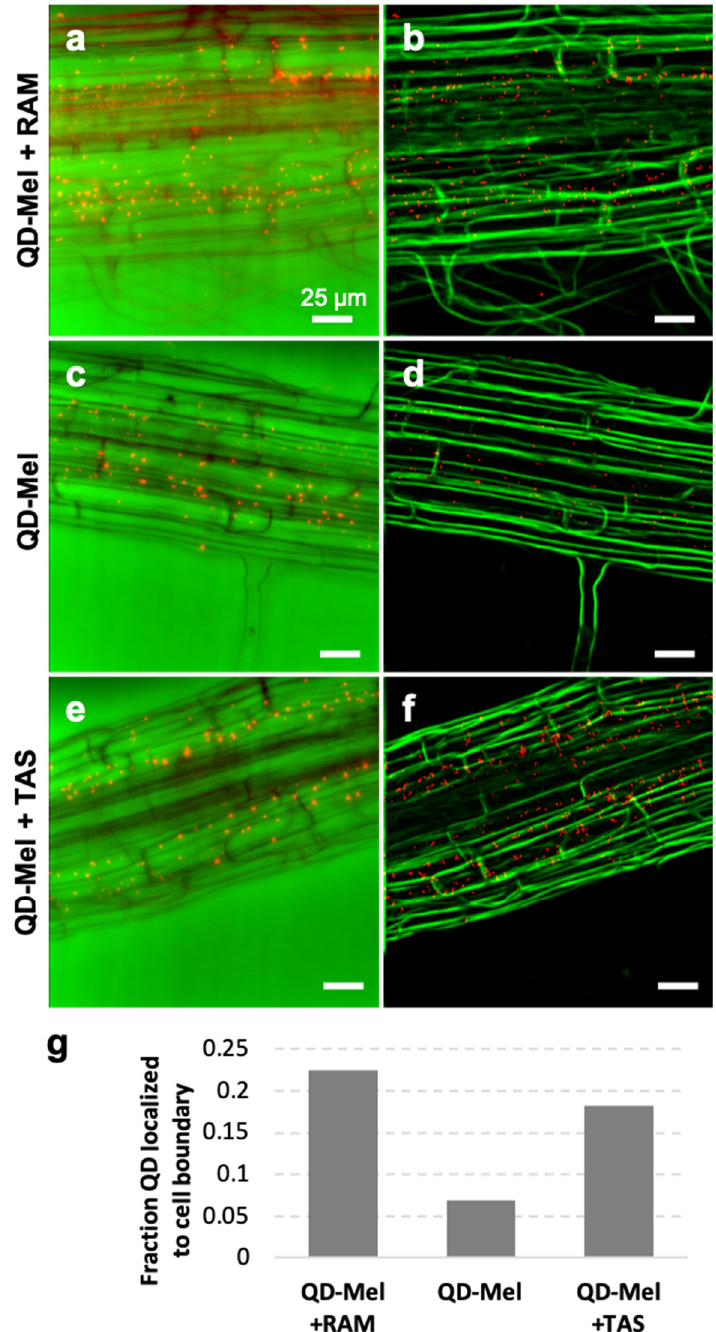
Figure 4. Arabidopsis thaliana roots treated with ramelteon + QD-MEL ( a , b ), QD-MEL alone ( c , d ), and tasimelteon + QD-MEL ( e , f ) seen under 40 × magnification with mCherry fluorescent filter. Images are pseudocoloured to show QD-MEL in red and overlaid on brightfield images in green; ( a , c , e ) are 2D projections of raw Z-stacks; ( b , d , f ) are post-processed images where detected QD-MEL (red) are overlaid with the probability map of cell boundaries (green). All scale bars are 25 µm. Arrows in ( a ) and ( e ) show QD-MEL aligned with cell boundaries; arrow in ( d ) indicates QD-MEL clearly inside cells. ( g ) Quantification of QD-MEL localization to cell boundaries, showing that QD-MEL + RAM and +TAS are significantly more localized to cell boundaries than QD-MEL alone.